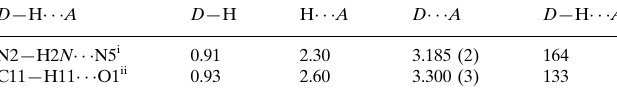
Hydrogen-bond geometry (A˚ , (cid:2)